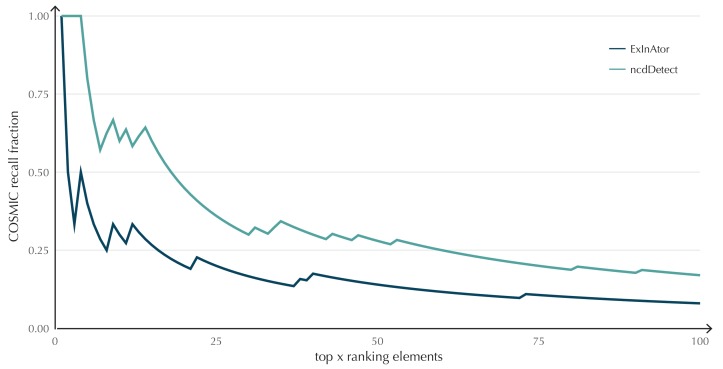
COSMIC Gene Census recall plot.The fraction of COSMIC genes recalled in the top ncdDetect and ExInAtor candidates.DOI:
http://dx.doi.org/10.7554/eLife.21778.04510.7554/eLife.21778.046Appendix 1—figure 3—source data 1.COSMIC Gene Census recall data.The fraction of recalled COSMIC genes in the top ncdDetect and ExInAtor candidates. This data set relates to Appendix 1—figure 3.